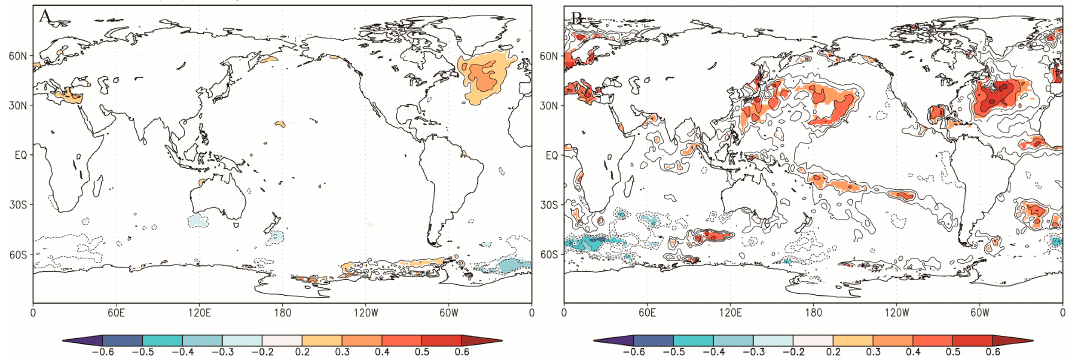
Figure 9. Correlation between the SPEI and sea surface temperature (HadISST1). ( A ) Relationship between the reconstruction and July-June HadlSST1(1870–2013) p < 10%; ( B ) Relationship between the reconstruction and July-June HadlSST1(1981–2010) p < 10%.